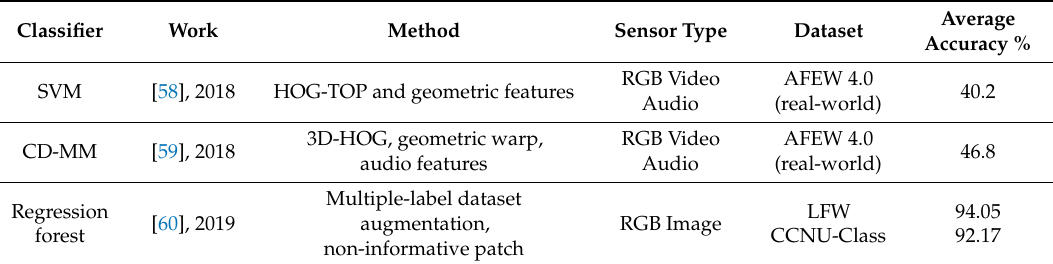
Table 3. Existing FER systems for resolving head pose